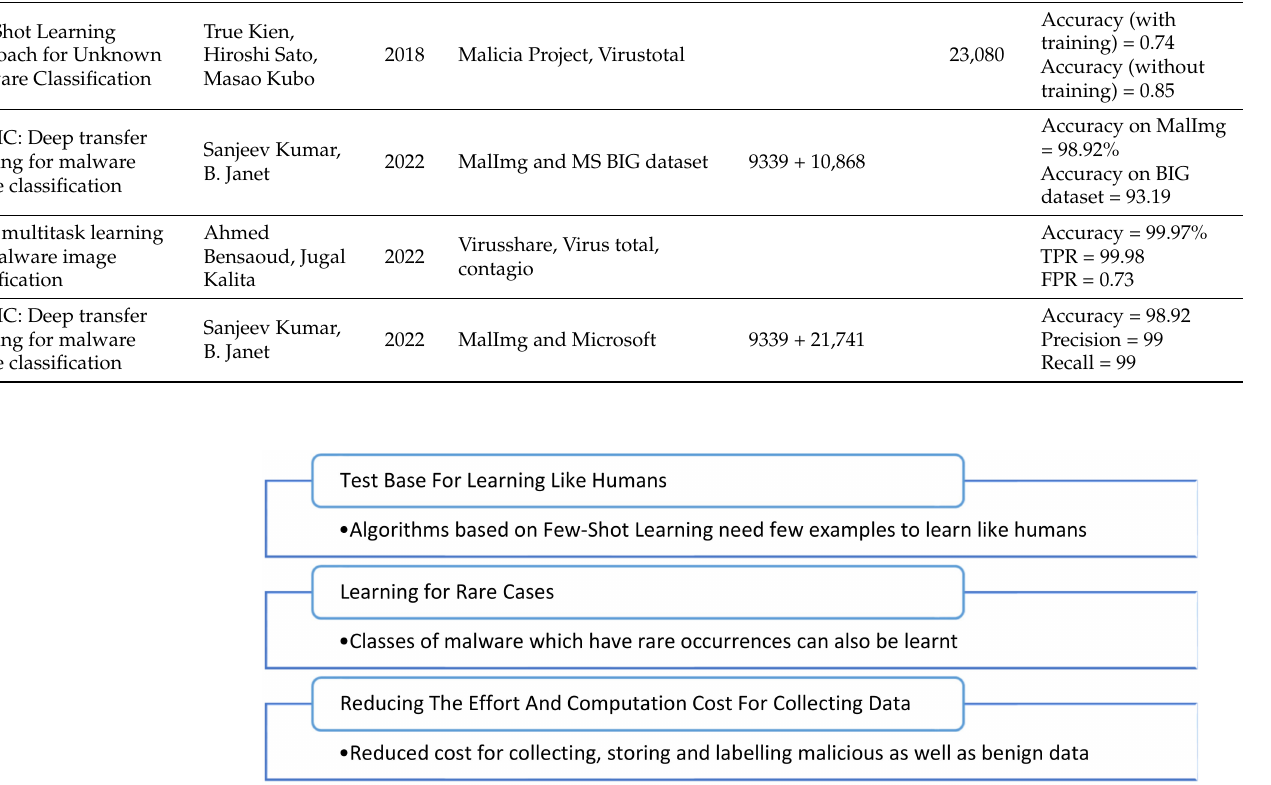
Figure 7. Advantages of Meta